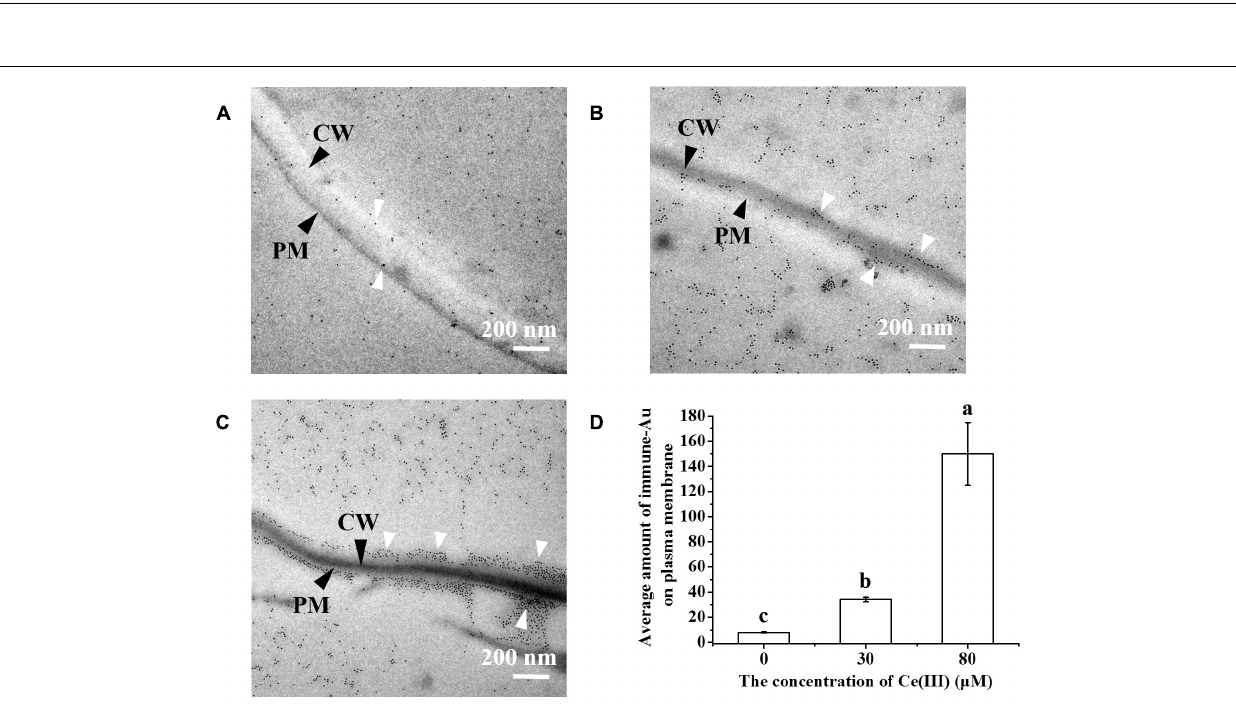
Frontiers in Plant Science |